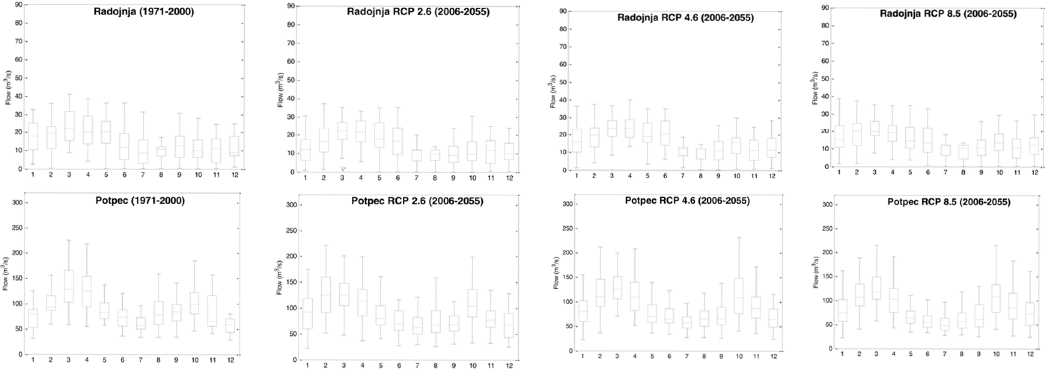
Figure 9. Box plots of the monthly inflows into the Lim water system (Uvac, Kokin Brod, Radojnja and Potpec).